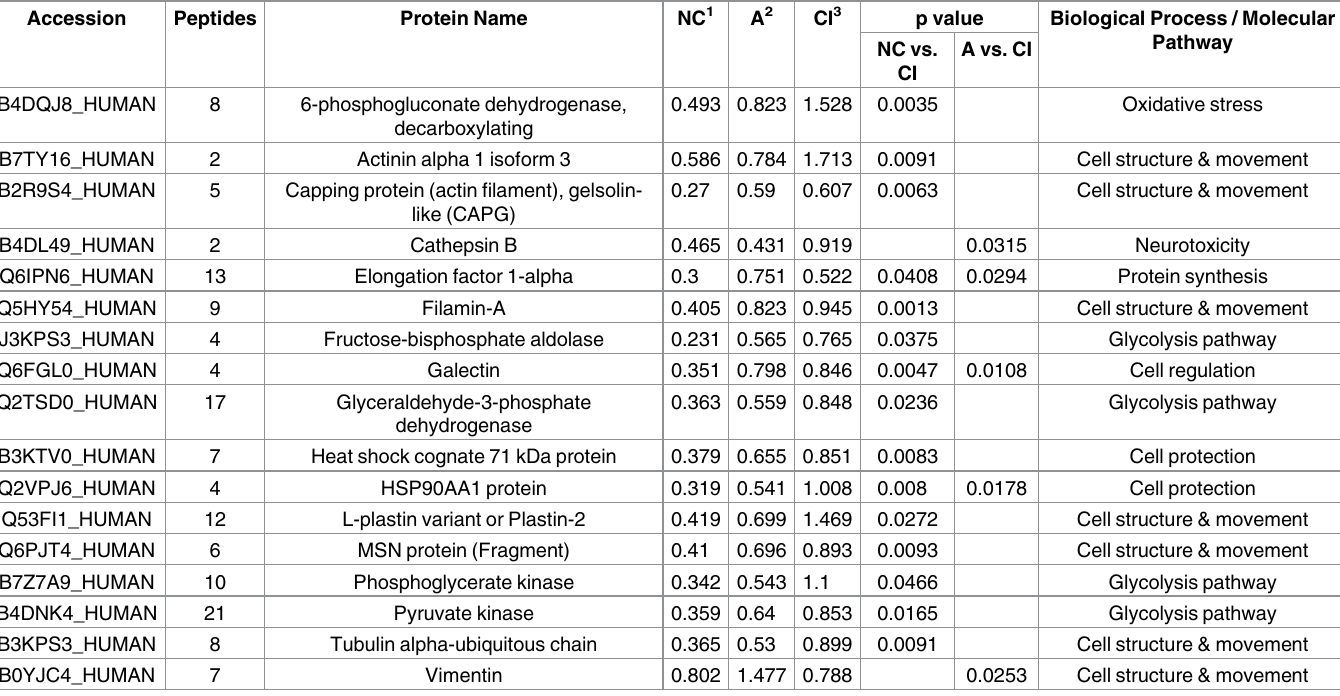
Table 2. List of proteins identified by TMT labeling and differentially expressedamong the HACI groups.